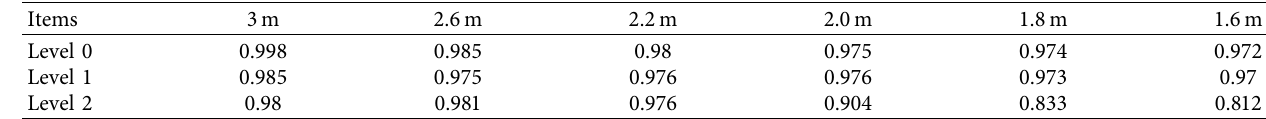
Table 12: Test results of actual beam bridge